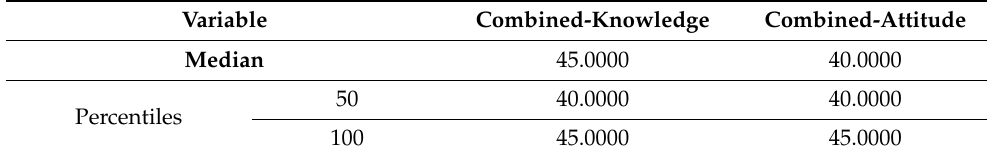
Table 4. The median of combined-knowledge and combined-attitude variables. Variable